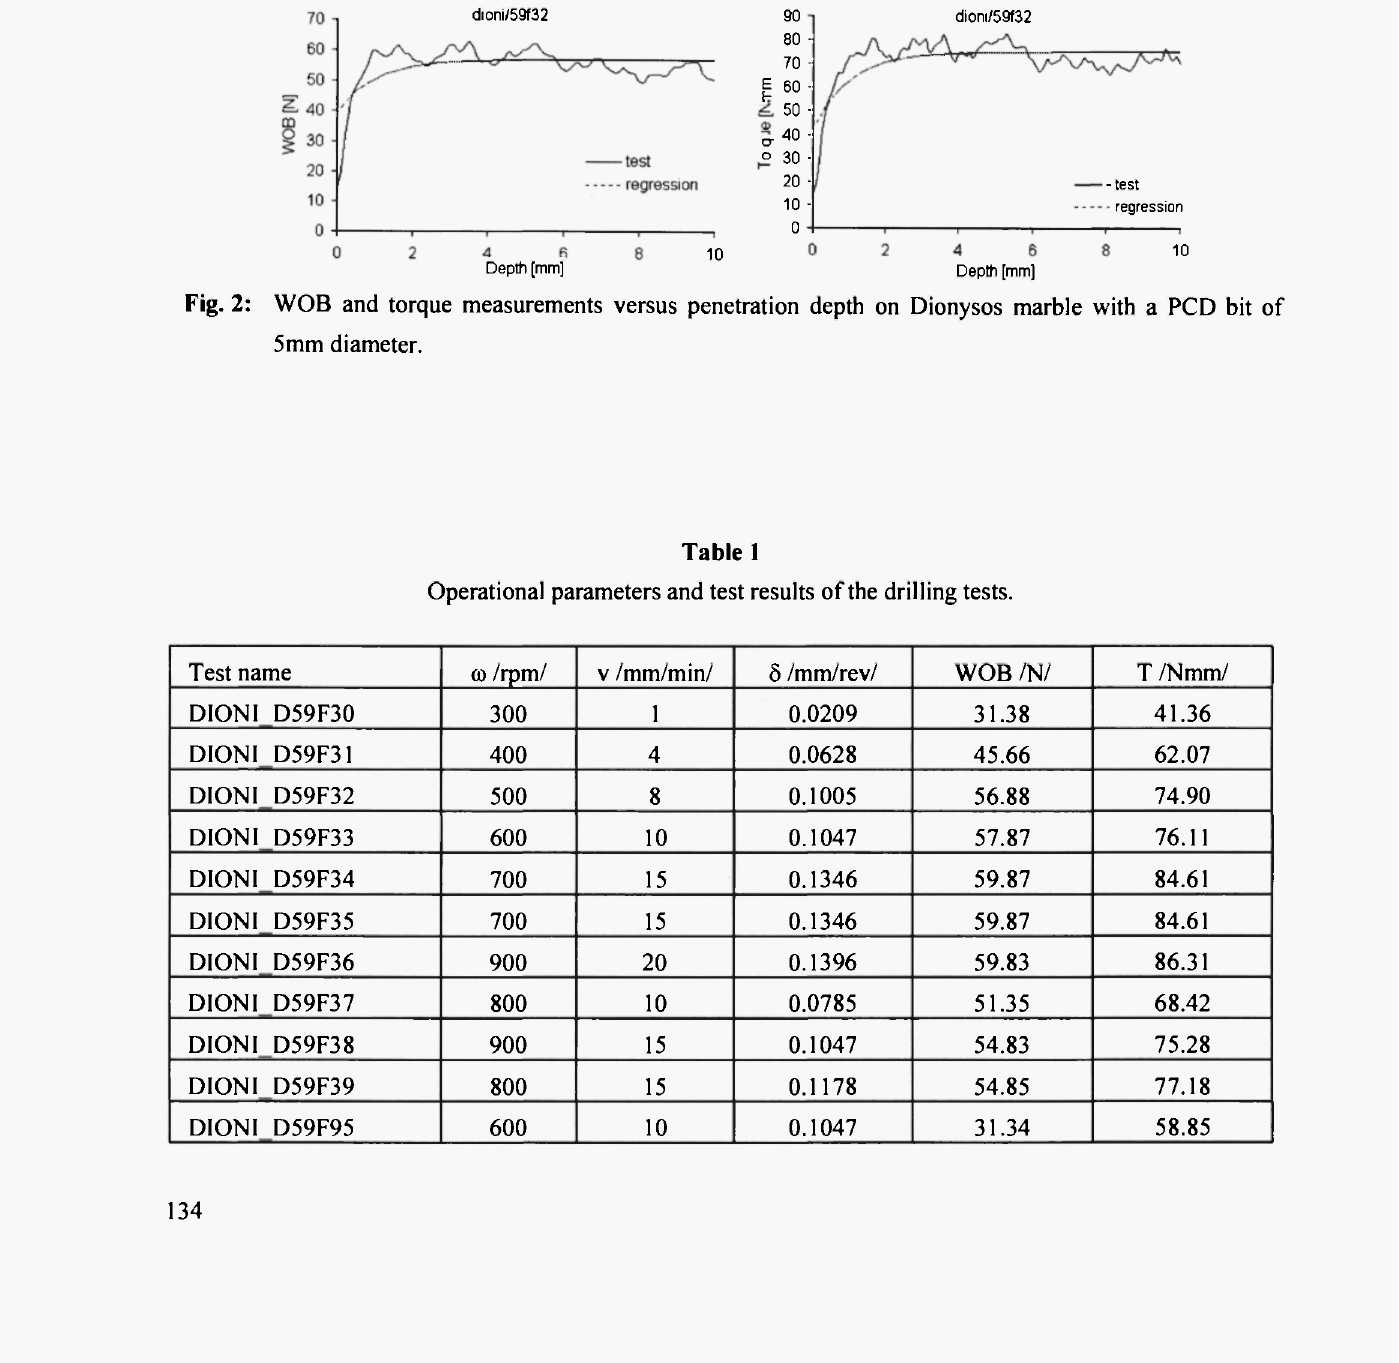
Fig. 2: WOB and torque measurements versus penetration depth on Dionysos marble with a PCD bit of 5mm diameter.